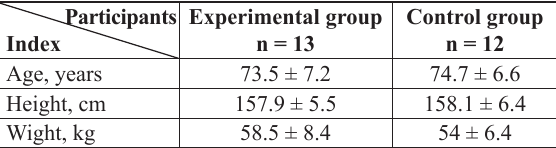
Table. Anthropometric characteristics of the